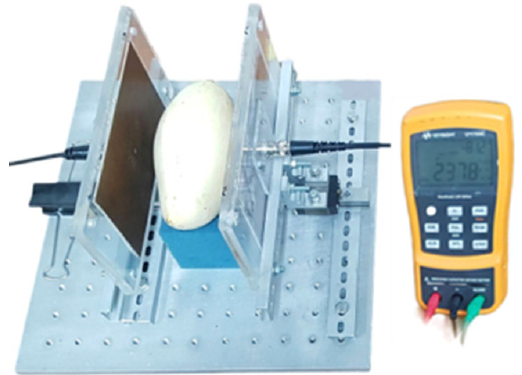
Figure 1. The parallel-plate capacitor